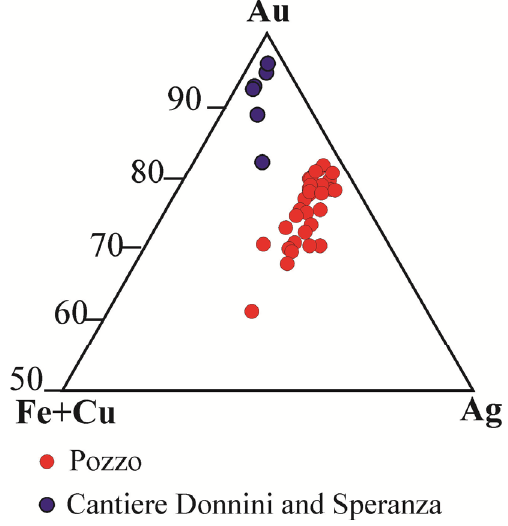
Figure 8. Composition of gold minerals, as at %, in the Au–Ag–(Fe + Cu) ternary diagram. Data of Cantiere Donnini and Speranza are from